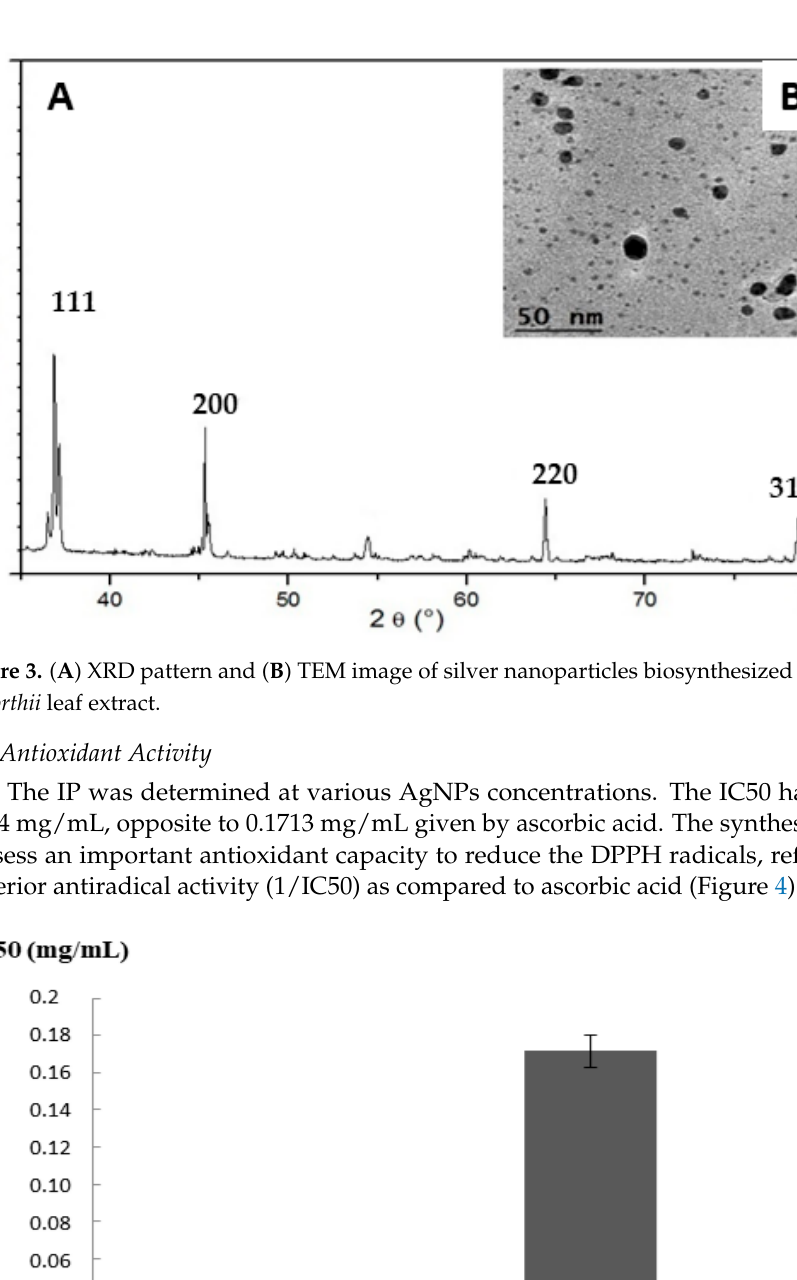
7 of 18 Figure 2. FT − IR spectrum of the AgNPs from Aeonium haworthii leaf extract. 3.1.2. Structural Study The X-ray diffraction (XRD) pattern of the biosynthesized AgNPs shows four dif- fraction peaks (Figure 3A). These major peaks correspond to the (111), (200), (220) and (311) planes, respectively, and reflect the patterns of the face-centered cubic (fcc). The size